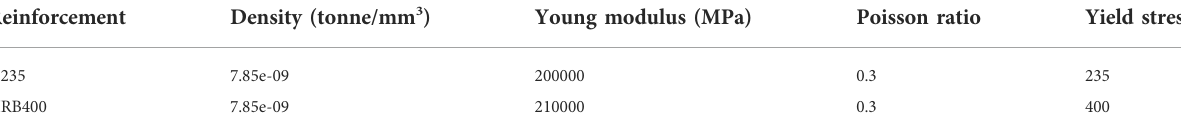
TABLE 2 Material parameters of reinforcement.